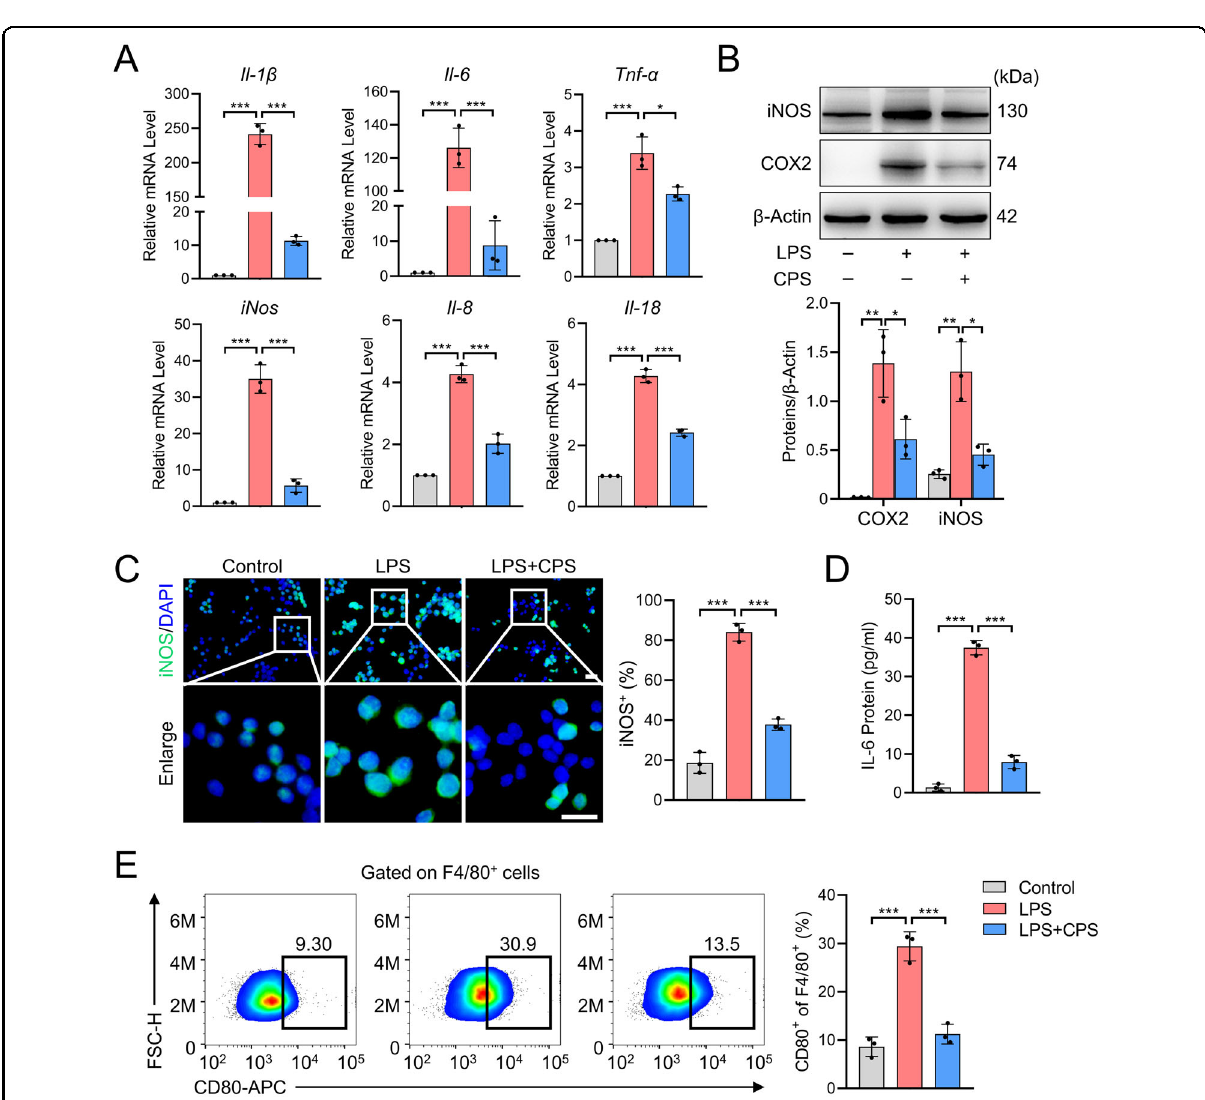
Fig. 3 TRPV1 inhibits M1 macrophage polarization in RAW264.7 cells. A qPCR analysis of mRNA levels of M1 macrophage markers in the cells treated with LPS with or without CPS for 24 h. B Western blot and quantitative analysis of iNOS and COX2 proteins in the cells treated with LPS with or without CPS for 48 h. C Immuno fl uorescence and quantitative analysis of iNOS in RAW264.7 cells treated with LPS with or without CPS for 48 h. D ELISA analysis of IL-6 levels in the supernatant of the culture medium of RAW264.7 cells treated with LPS with or without CPS for 48 h. E Flow cytometry for detection and quantitative analysis of F4/80 + CD80 + cells after the treatment of LPS with or without CPS for 48 h. Data ( n = 3) are shown as mean ± SD. * P < 0.05; ** P < 0.01; *** P < 0.001. Scale bars: 25 μ